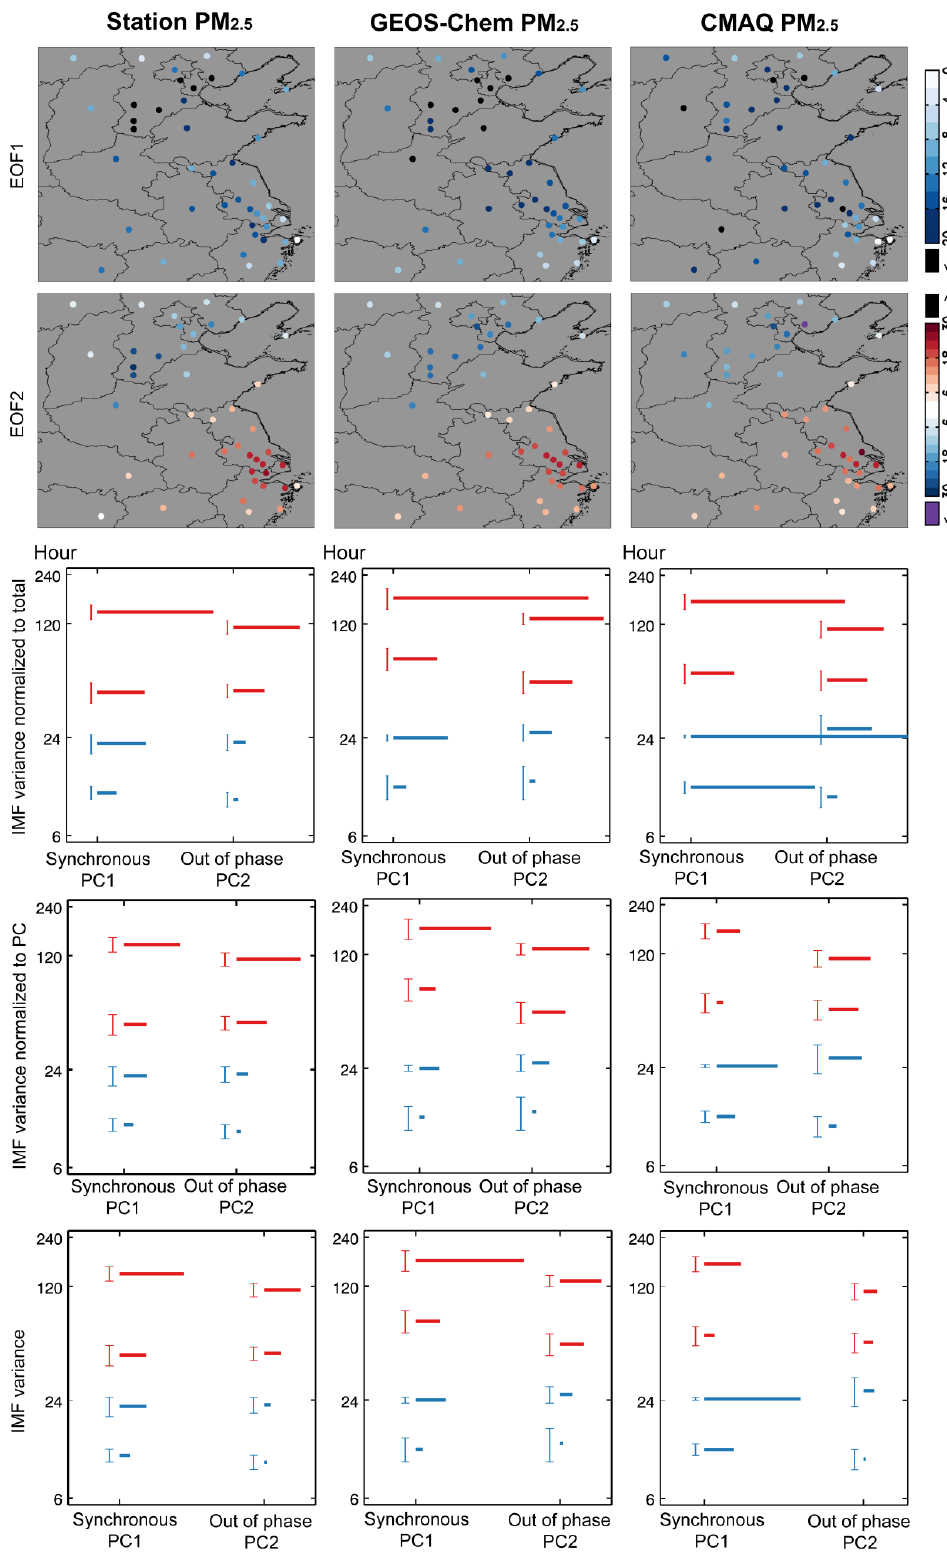
Figure 11. EOF–EEMD results for observed, GEOS-Chem, and CMAQ PM 2 . 5 . See Sect. 4.2 for detailed descriptions.